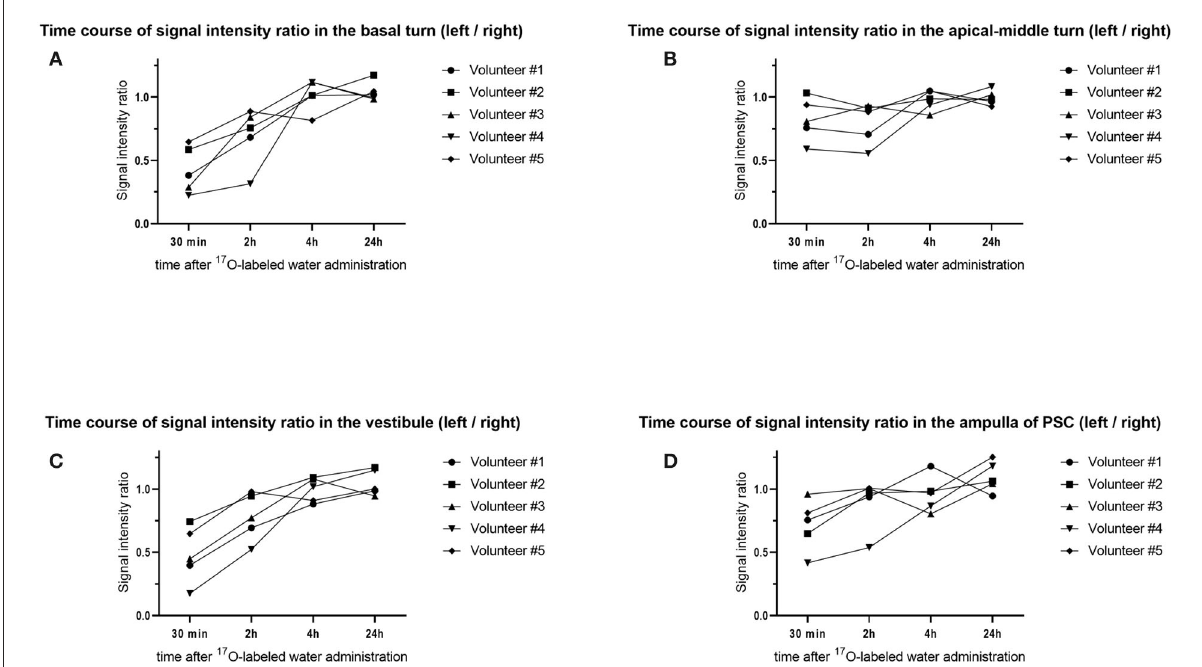
FIGURE10 Time course of the signal–intensity ratio (SIR) in the five volunteers. The vertical axis shows the SIR and the horizontal axis shows the time elapsed since injection of the 17 O-labeled water. Using the signal value for the right side as a control, each SIR was calculated as the signal intensity of the region of interest/signal intensity of the right ear. Time course of the SIR in (A) the basal turn of the cochlea, (B) the apical–middle turn of the cochlea, (C) the vestibule, and (D) the ampulla of the posterior semicircular canal (PSC). Note that the distribution of 17 O-labeled water in the basal turn of the cochlea and vestibule at 30min is obvious but is not obvious in the apical–middle turn. For the ampulla of the PSC, the distribution of 17 O-labeled water at 30min was seen in four